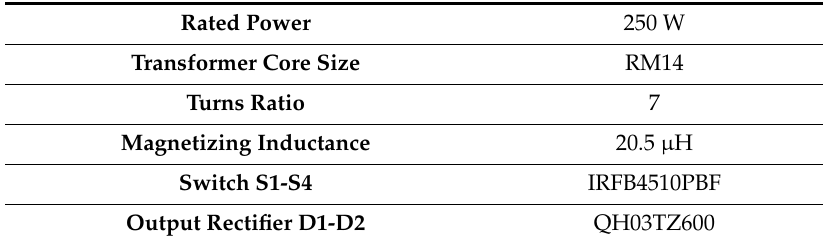
Figure 10. The experimental setup for the LLC resonant converter. Figure 10 . The experimental setup for the LLC resonant converter. Table 1. Experimental prototype parameters.